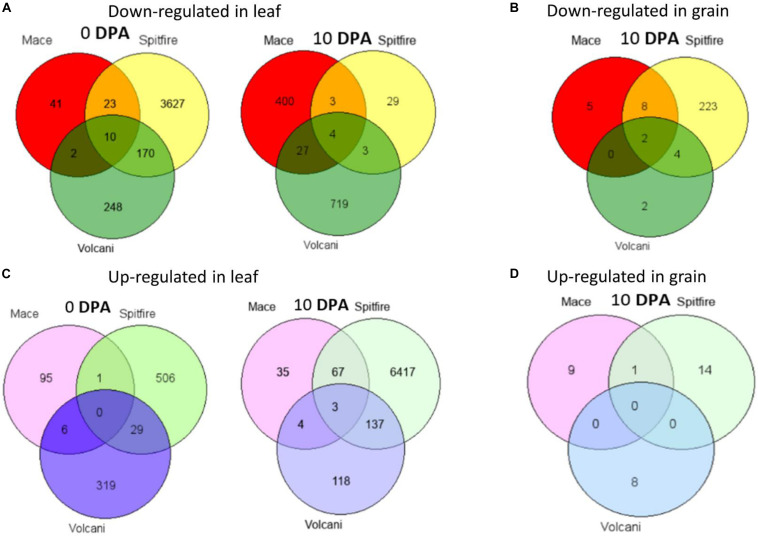
Venn diagrams of DEGs shared among Mace, Spitfire, and Volcani in leaf and grain tissues at two development stages. (A) The number of down-regulated genes in leaf. (B) The number of down-regulated genes in grain. (C) The number of up-regulated genes in leaf. (D) The number of up-regulated genes in grain. Differentially expressed genes (DEGs), 0 days post anthesis (0 DPA), 10 days post anthesis (10 DPA).